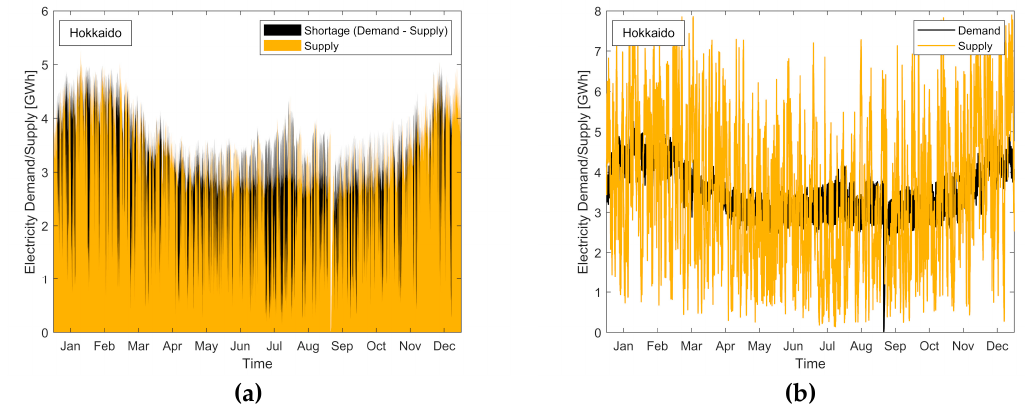
Figure 6. Electricity supply and demand for Hokkaido: ( a ) Based on 80% of the electricity being supplied by offshore wind without storage (762 turbines) and ( b ) based on the assumption that the net produced electricity is the same as the net electricity demand (760 turbines).